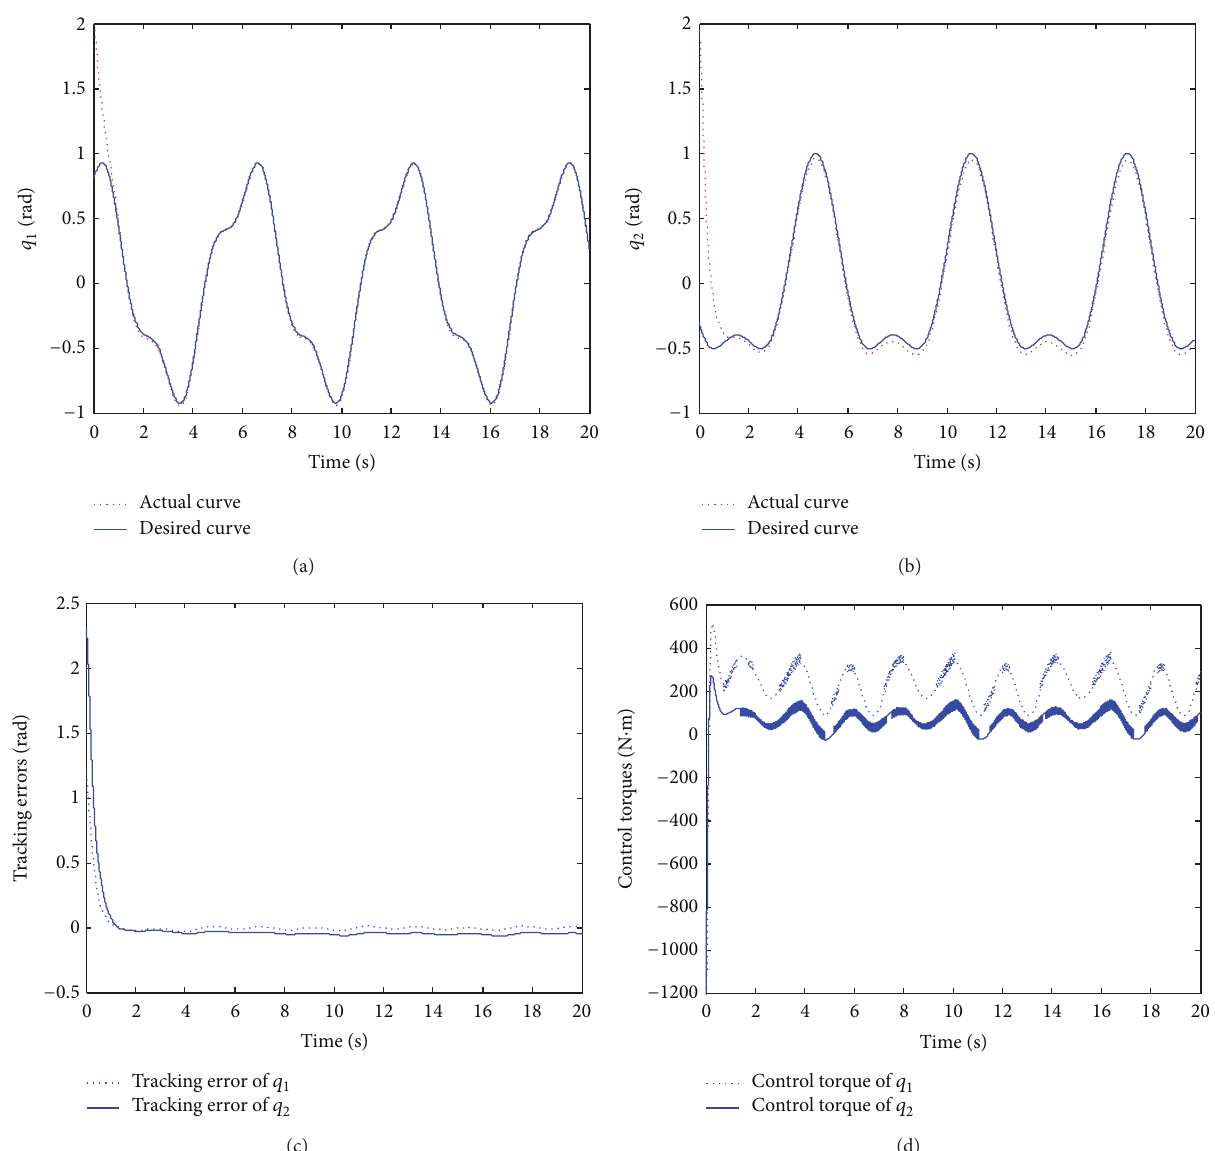
Figure 4: The proposed adaptive robust quadratic stabilization tracking control for robotic manipulator. (a) Tracking curve of 𝑞 1 , (b) tracking curve of 𝑞 2 , (c) tracking errors, and (d) control